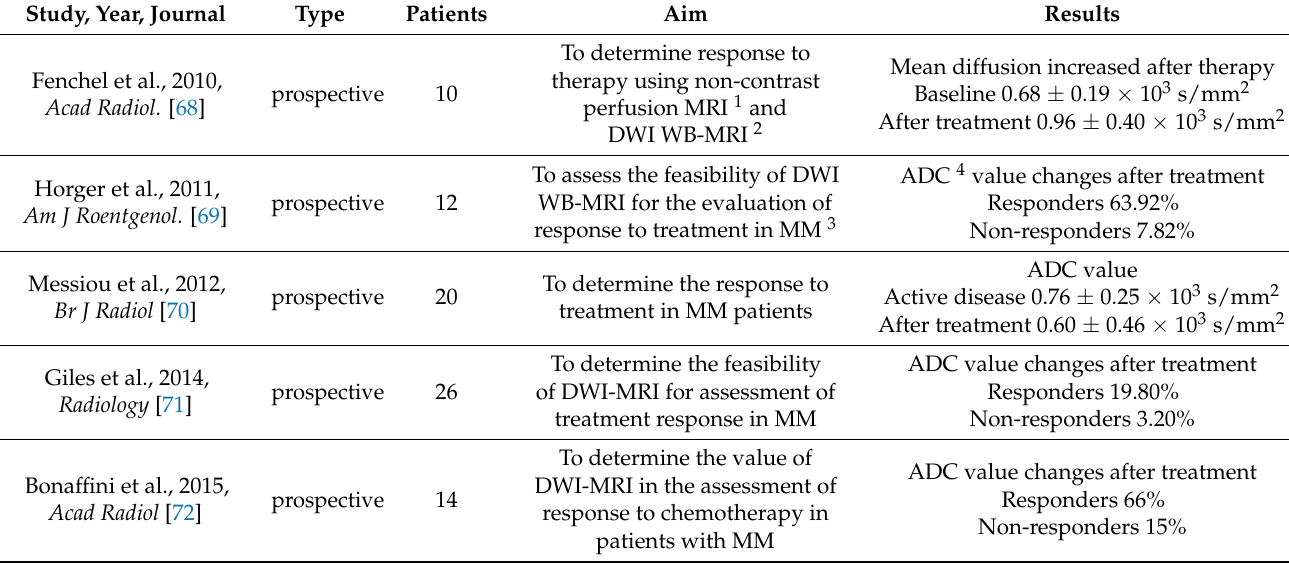
Table 2. Main studies assessing the performance of DWI-MRI for treatment response in MM